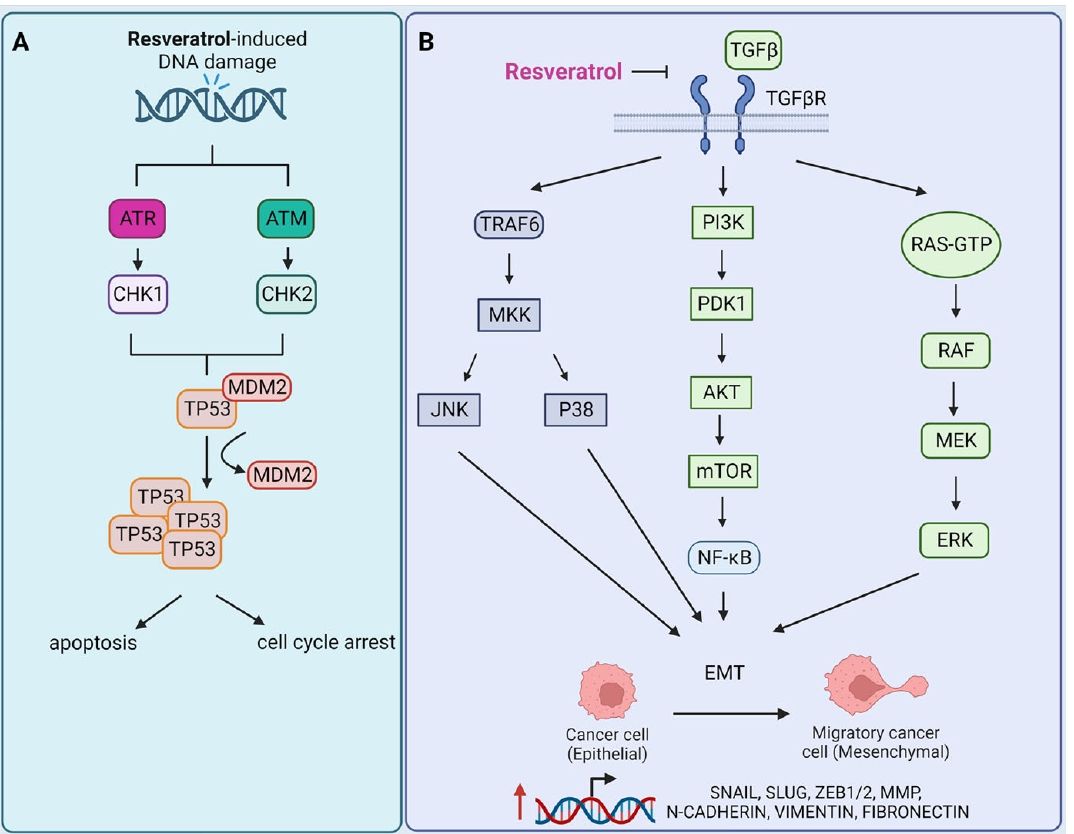
Figure 5. ( A ) Resveratrol can induce DNA damage, resulting in the recruitment of ataxia teleangi ‐ ectasia mutated (ATM)/ataxia teleangiectasia and RAD3 related (ATR) kinases that phosphorylate checkpoint kinase 1 (CHK1)/checkpoint kinase 2 (CHK2) serine ‐ threonine kinases. This prevents the interaction of tumor protein P53 ( TP53 ) with mouse homolog of double minute 2 (MDM2), thereby protecting the TP53 protein from degradation. TP53 induces the expression of genes in ‐ volved in cell cycle arrest and apoptosis. ( B ) Epithelial–mesenchymal transition (EMT) is initiated by many factors, including the activation of transforming growth factor β receptor (TGF ‐β R) by the native ligand transforming growth factor β (TGF ‐β ). This event initiates the signaling through rat sarcoma virus ‐ GTP (RAS ‐ GTP)/RAF proto ‐ oncogene serine/threonine ‐ protein kinase (RAF)/mitogen ‐ activated protein kinase (MEK)/extracellular signal ‐ regulated kinase (ERK) and phosphoinositide 3 ‐ kinase (PI3K)/phosphatidylinositol kinase (PDK ‐ 1)/protein kinase B (AKT)/mammalian target of rapamycin (mTOR)/ nuclear factor kappa ‐ light ‐ chain ‐ enhancer of ac ‐ tivated B Cells (NF ‐κ B) pathways, resulting in the expression of EMT ‐ related factors. EMT can also be promoted by c ‐ Jun N ‐ terminal kinase (JNK) and p38 kinase, which are members of the mito ‐ gen ‐ activated protein kinase (MAPK) pathway. They are activated by MAP kinase (MKK) and TNF receptor ‐ associated factor 6 (TRAF6) with K63 ‐ linked polyubiquitin chains by TGF ‐β‐ dependent polyubiquitinylation. Resveratrol inhibits TGF ‐β and TRAF6, preventing EMT of can ‐ cer cells. Created with BioRender.com (accessed on 22 March 2023). Due to its high therapeutic potential and success in preclinical studies, resveratrol has moved into clinical trials. The first reports in vitro and in vivo, focusing on the pharmacokinetics and safety of the substance, showed that the concentrations used in tests are not achievable in humans [170]. The low systemic availability is most likely at ‐ tributed to the compound’s rapid metabolism. Moreover, resveratrol exhibited a non ‐ linear dose ‐ response relationship. In phase, I clinical trial (NCT0098969, University of Michigan